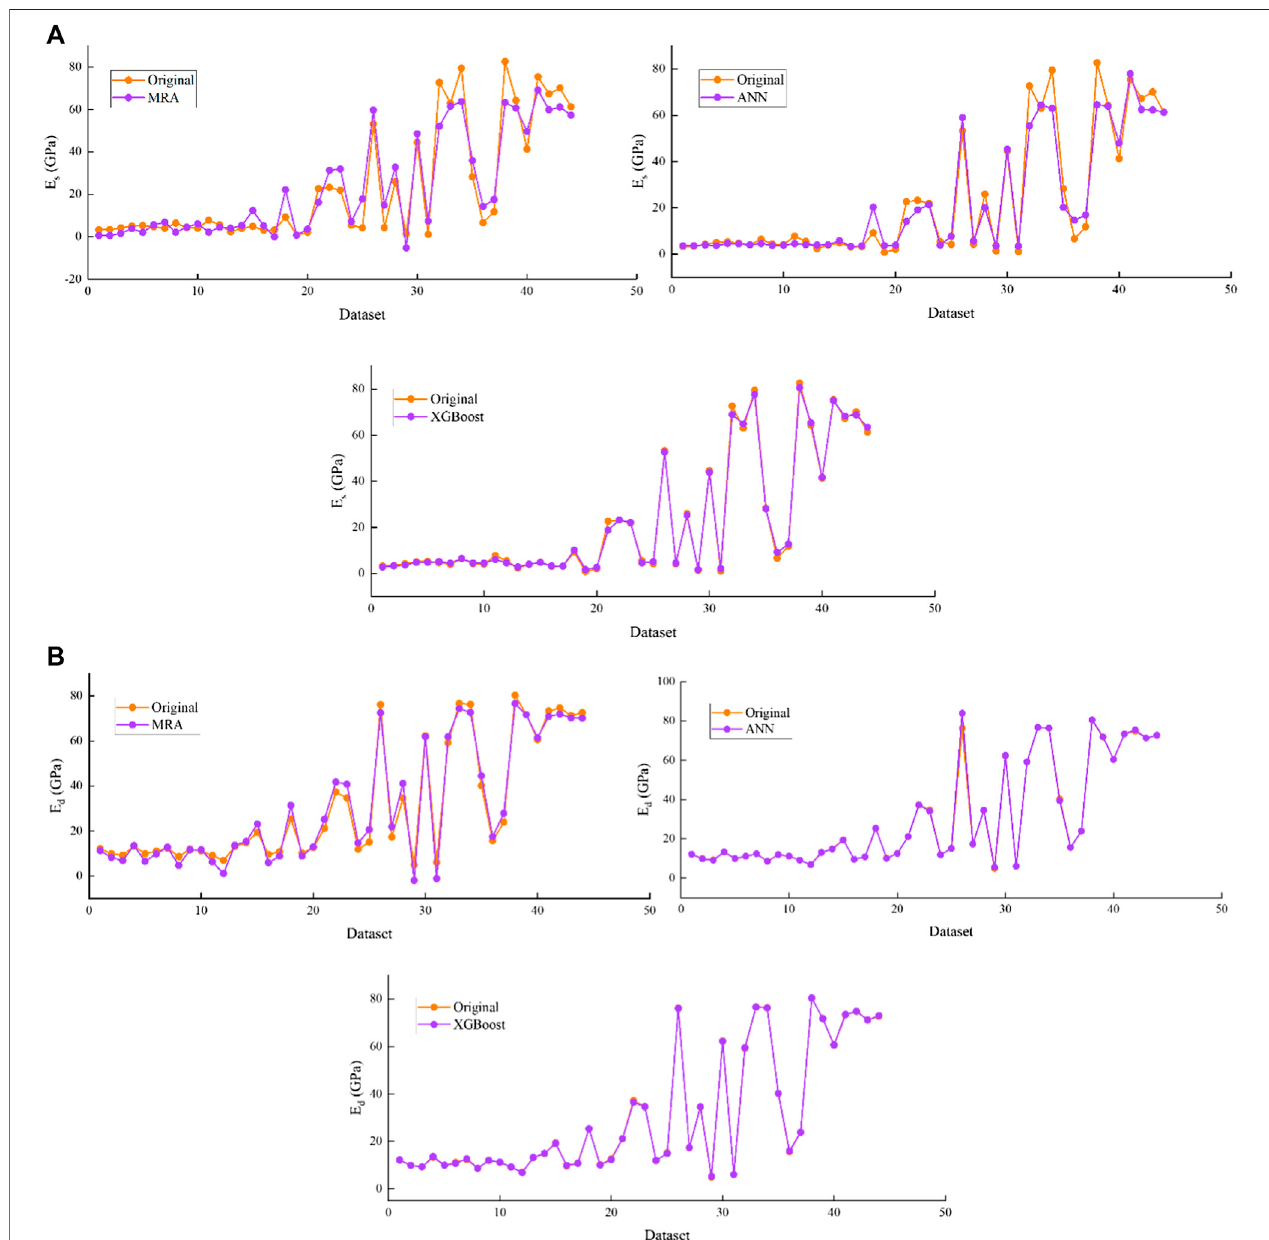
FIGURE 8 | Demonstration of predicted against original data of proposed models in the training stage for (A) E s and (B) E d . Mean Square Error Mean square error (MSE) is the mean of the square of all errors and is one of the important metrics for evaluating the performance of the corresponding models. The computation of MSE can be expressed by Eq. 11 .